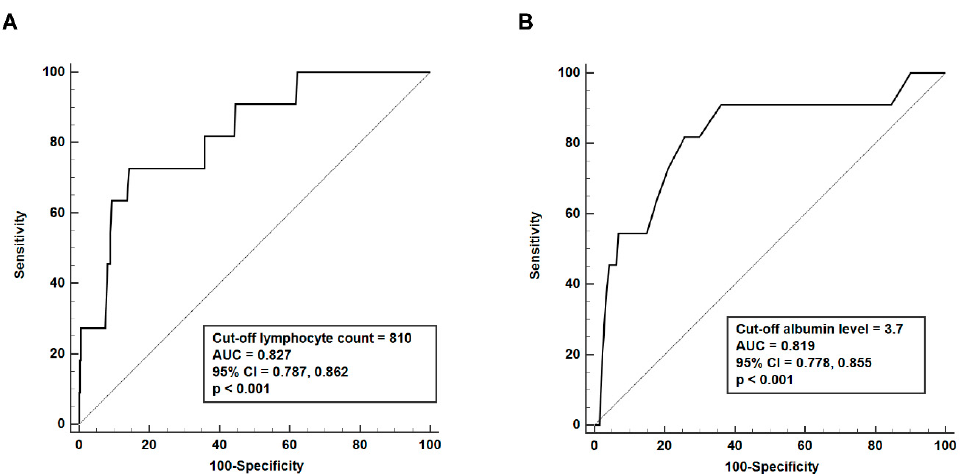
Figure 2. Cut-off values of absolute lymphocyte count and albumin levels associated with indeterminate results. In the receiver operating characteristic curve analysis, ( A ) a lymphocyte count of ≤ 810 mm 3 or ( B ) an albumin level of ≤ 3.7 mg/dL was capable of discriminating between indeterminate and determinate results of interferon-gamma release assays. AUC: area under the curve; CI: confidence interval.